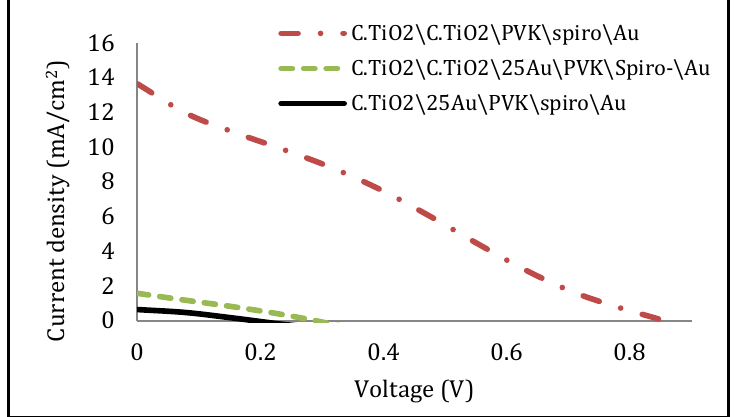
Figure 6: J-V characteristics of PSKs with thin Au layer between ETL and